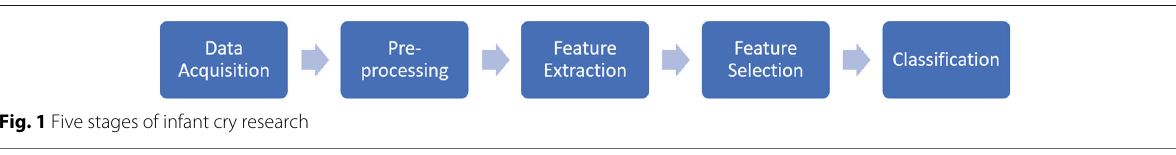
speech corresponding to one of the five “Dunstan words,” which were translated as “Neh” = hungry, “Eh” = need to burp, “Oah” = tired, “Eairh” = low belly pain, and “Heh” = physical